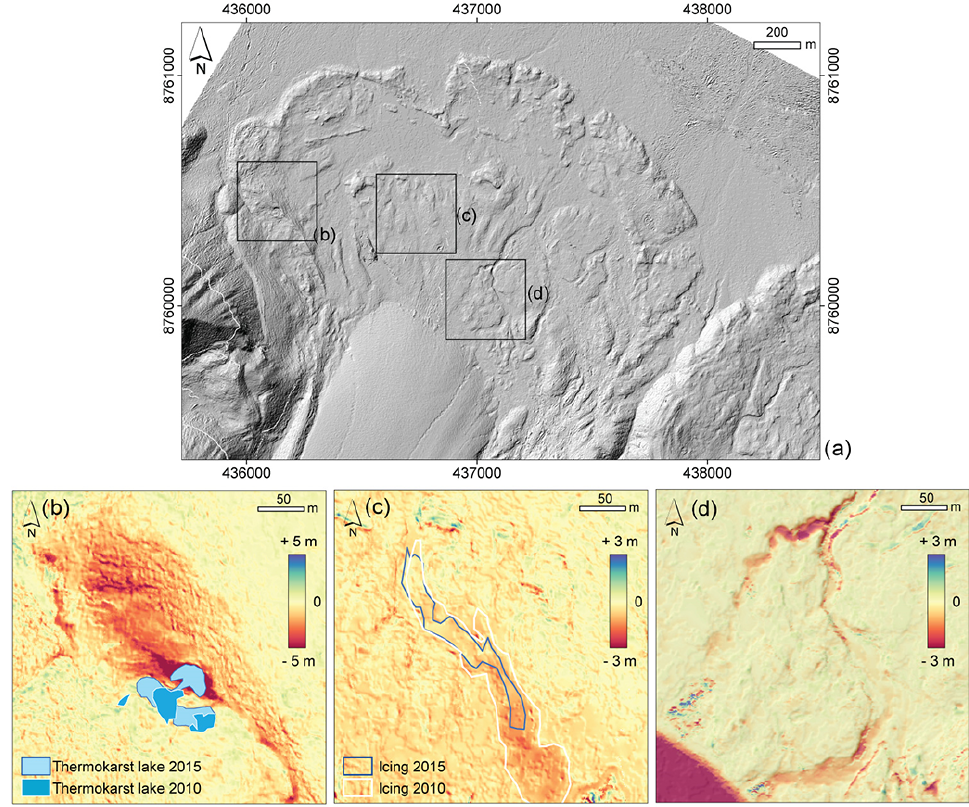
Figure 14. (a) Hillshade of the glacier forefield from the 2015 GoPro-derived DEM. Rectangles (b–d) indicate the location of respective panels of the lower row of the figure. (b) Elevation changes 2010–2015 over a section of the lateral ice-cored moraine with the position of thermokarst lakes indicated. (c) Elevation changes 2010–2015 over a section of the central forefield with icing. (d) Elevation changes 2010– 2015 over proglacial channels; glacier terminus to the lower left; elevation changes underlain by the hillshade to better indicate channel